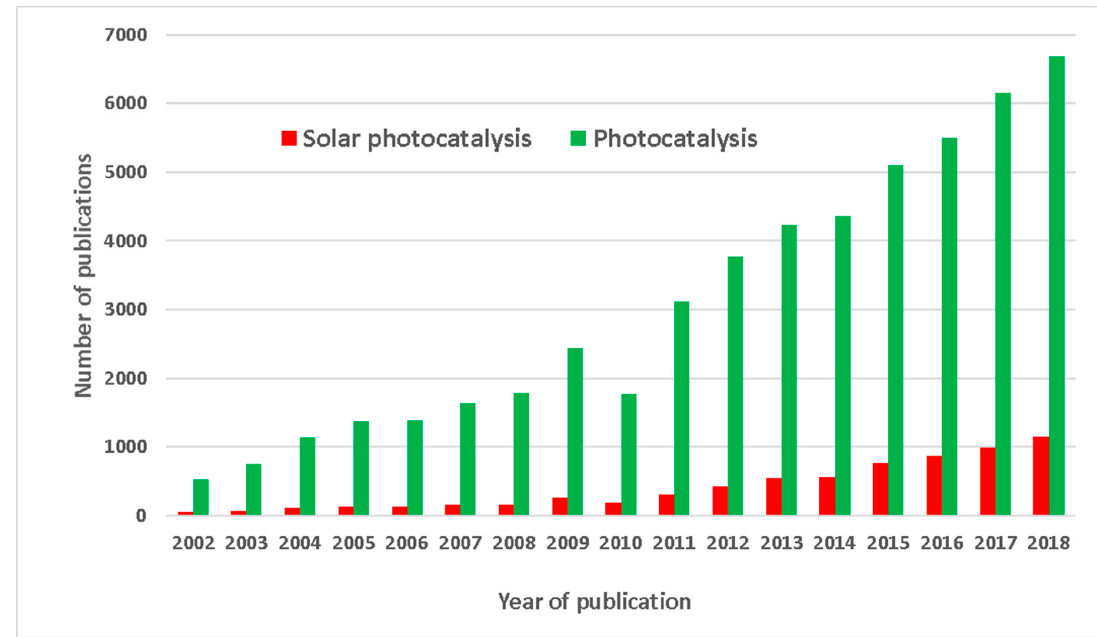
Figure 8. Publications on photocatalysis compared to those on solar photocatalysis. Data from Scopus comparing “photocatalysis” with “solar AND photocatalysis” as search terms within the “article title,